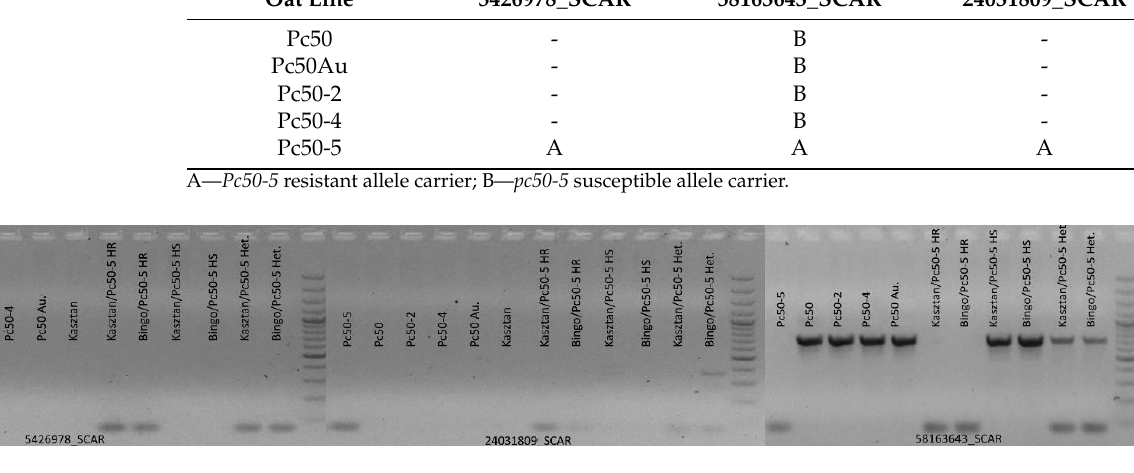
Figure 3. PCR markers validation on Pc50 isolines (Pendek × CW 486-l) and progeny of F 2 Kasztan Pc50-5 and Bingo × Pc50-5 populations. HR — homozygous resistant; HS — homozygous susceptible; Het. — heterozygous.